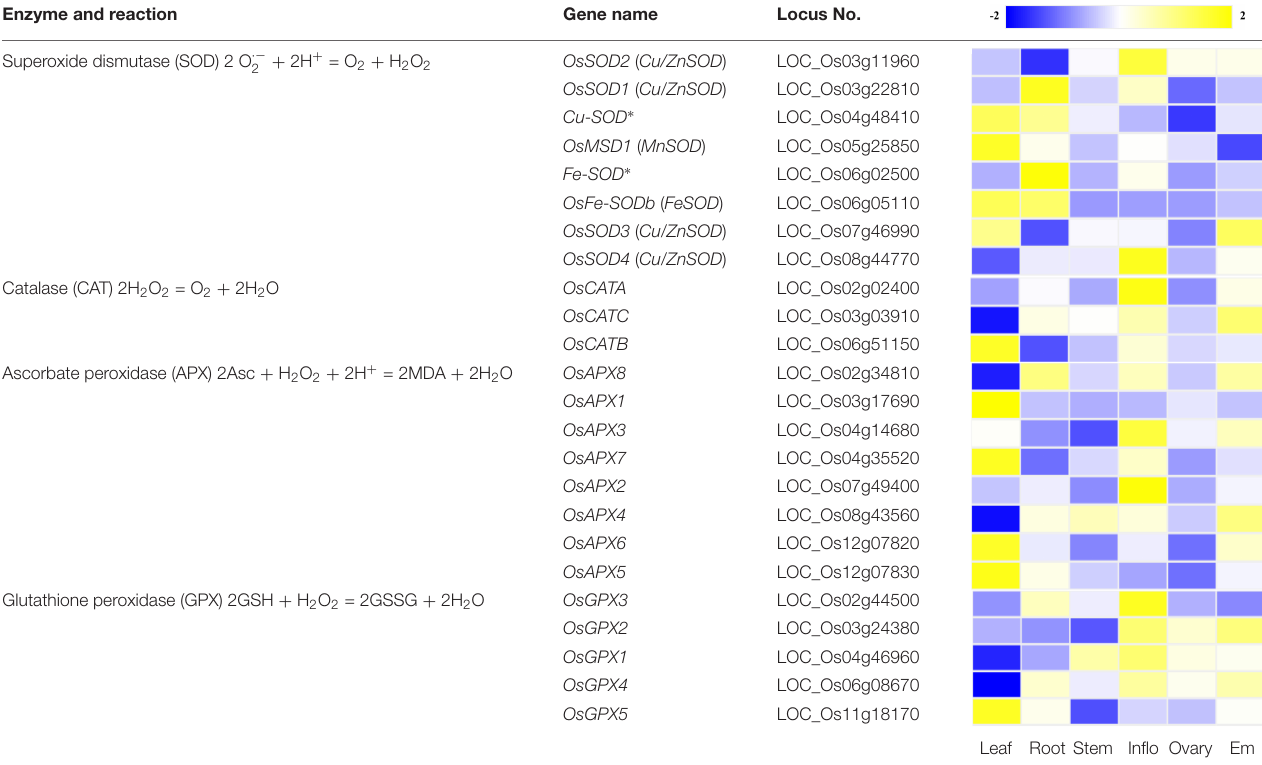
TABLE 1 | Genes that participate in the removal of ROS and their expression profiles in various rice tissues and organs. Enzyme and reaction Gene name Locus